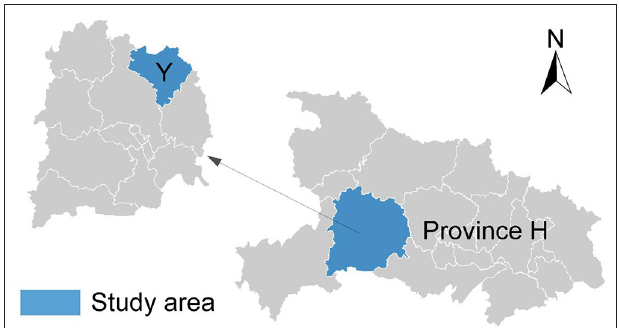
FIGURE 1 | Location of the study